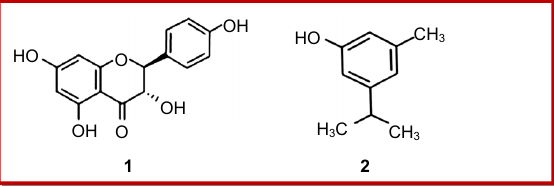
Figure 1: Structure of isolated compounds